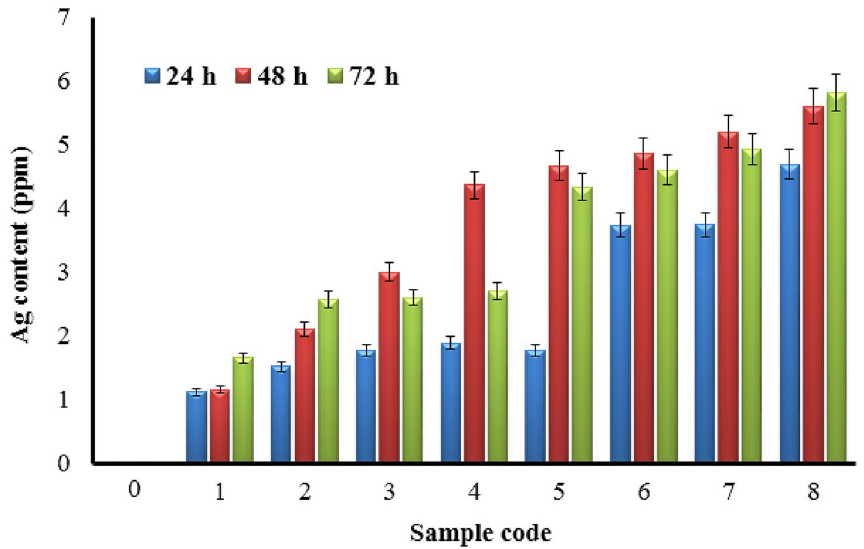
Figure 7. In vitro release of deposited SNPs from coated (Samples 1–8) fabrics. Uncoated fabric (Sample 0) included as blank in the experiment. Sample 0 (Uncoated fabric), Samples 1–4 and 5–8 (NS-coated fabrics at 2, 10, 20, and 50 mM silver nitrate concentrations, and 25 and 50 min sonication time,